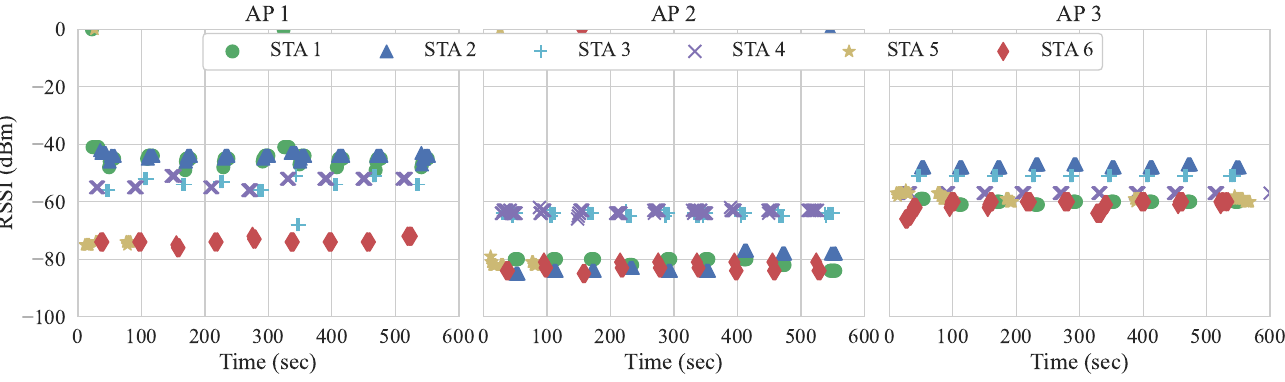
Figure 13. Received Signal Strength Indicator (RSSI) of STAs per AP with an initial STA/AP